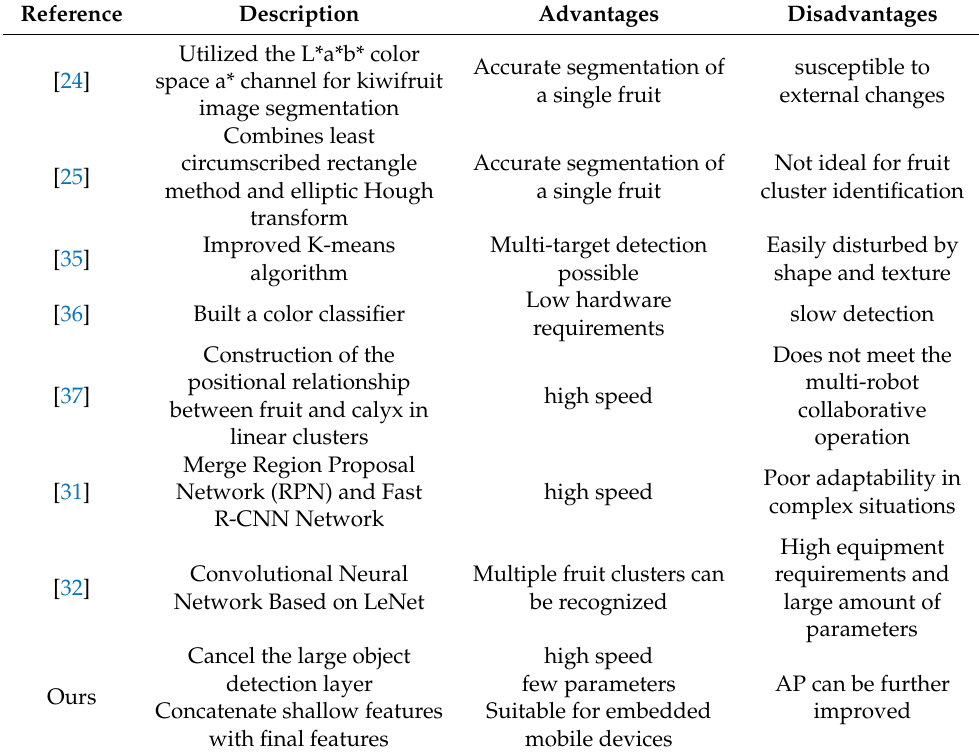
Table 4. Comparison and analysis of advantages and disadvantages of